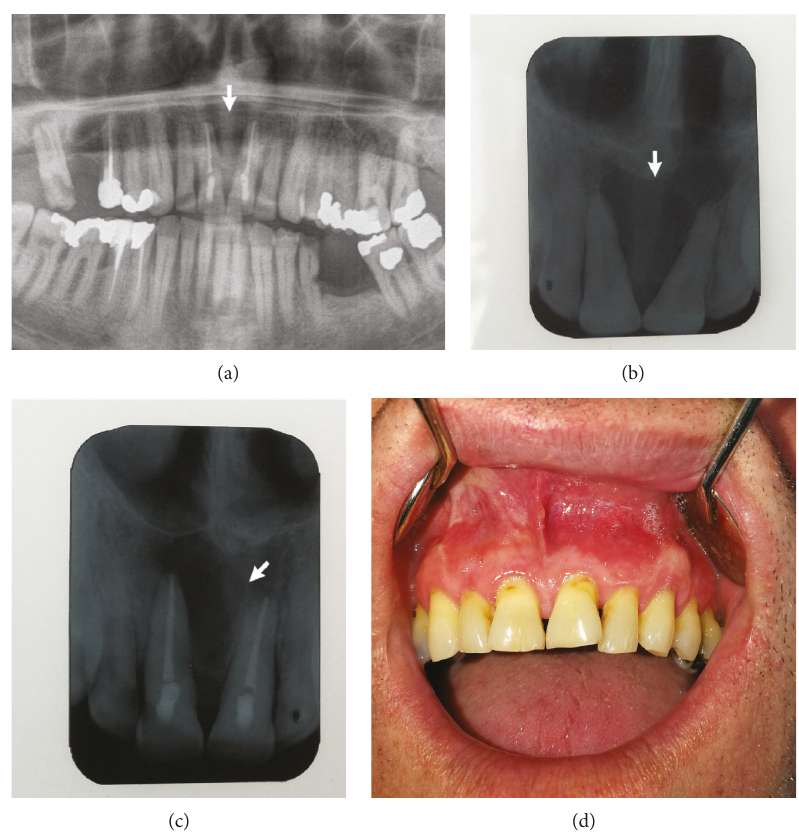
Figure 12: Follow-up period one 1 year after surgery. (a) OPG with no signs of radiolucency. (b) Preoperative X-ray with obvious signs of radiolucency. (c) Postoperative X-ray one year after surgery with signs of bone regeneration in progress. (d) Clinical appearance of vestibular mucosa one year after surgery (no swelling, no in fl